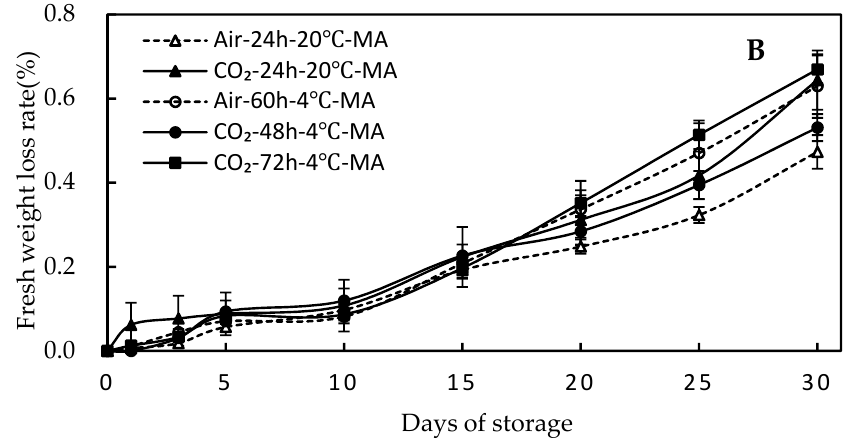
Figure 3. Changes in fresh weight-loss rate of green asparagus treatments with 60% CO 2 packaged with MA and P films. ( A ) Perforated packages (P); ( B ) 10,000 cc / m 2 · day · atm oxygen transmission rate (OTR)-modified atmosphere packages (MA). All groups were stored at 4 °C until the final day. Values are presented as means ± SE ( n = 5).